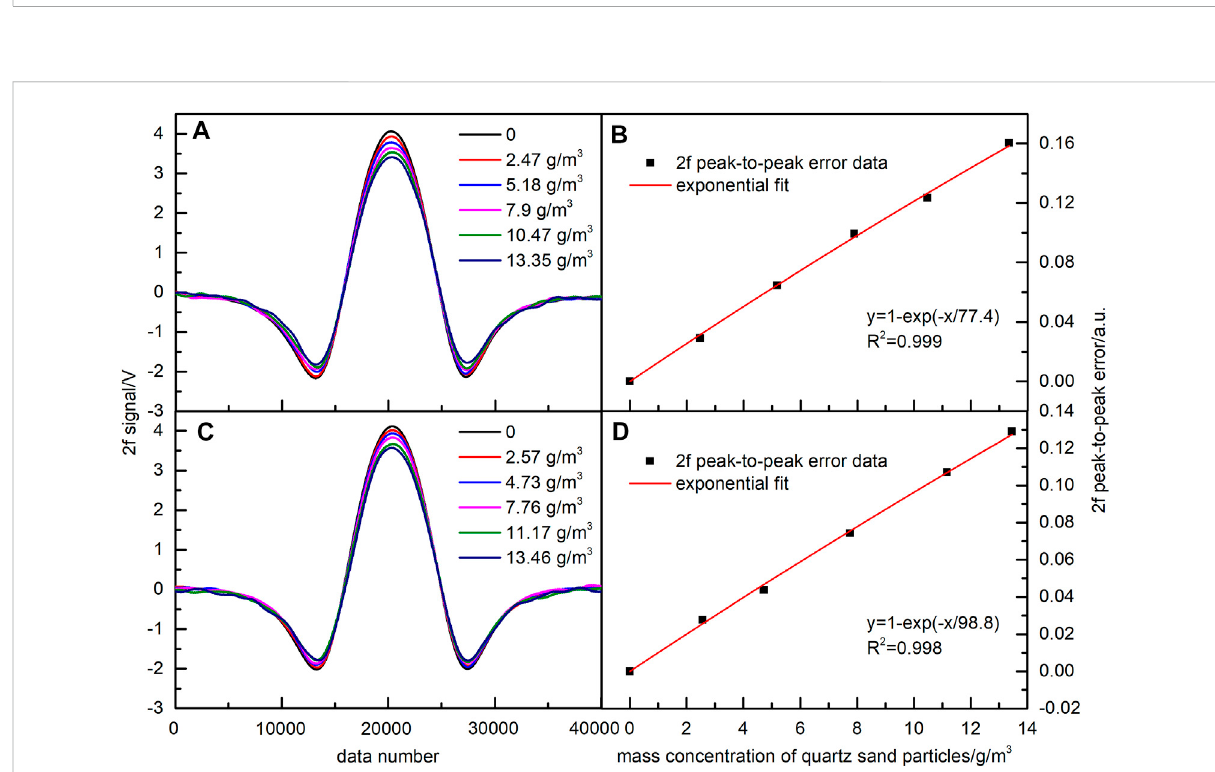
FIGURE 5 Effect of quartz sand on the NO 2f signal. (A) 2f signal with removed background (97 – 105 μ m). (B) Exponential fi tting function of 2f peak-to- peak error corresponding to Figure 5A. (C) 2f signal with removed background (105 – 135 μ m). (D) Exponential fi tting function of 2f peak-to-peak error corresponding to Figure